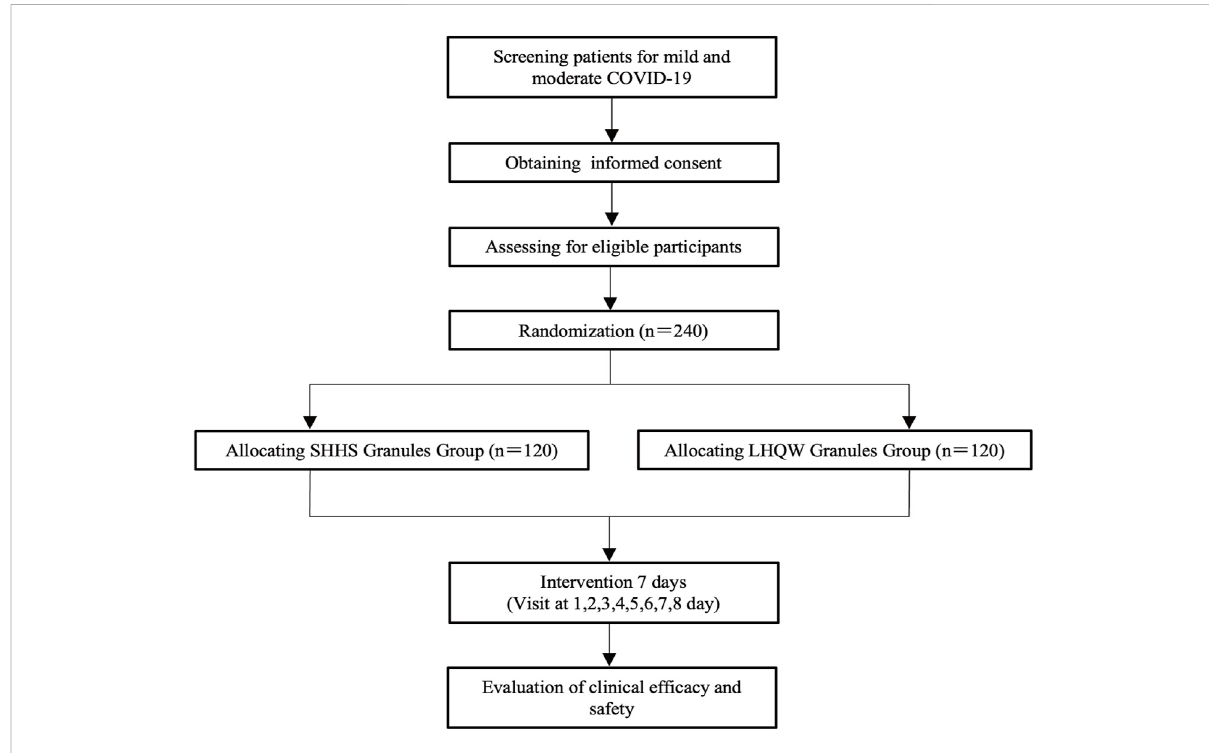
FIGURE 1 Flow diagram of the